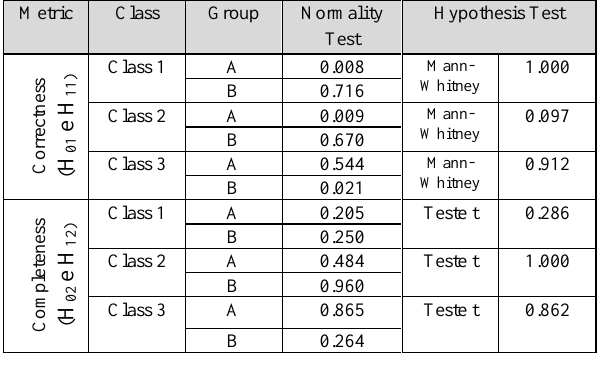
TABLE VIII. R ESULTS FROM THE HYPOTHESES TESTS REGARDING THE QUALITY INDICATORS OF THE MOCKUPS .